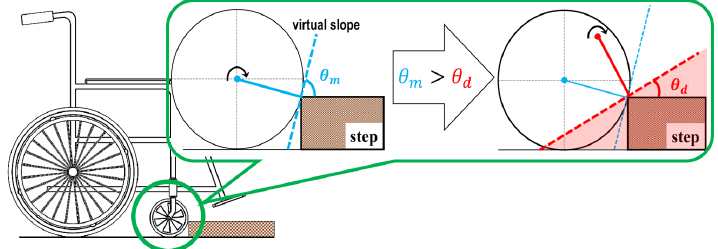
Figure 1. Conceptual illustration of gradient minimization for mobility